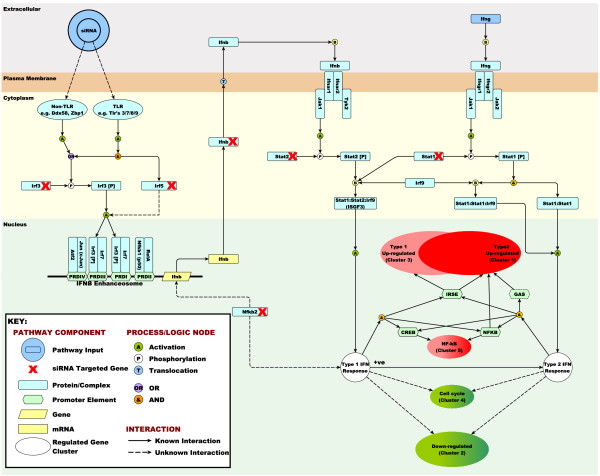
Model of known components of the IFN signalling pathway and explanation of observed results. Transfection of siRNA using Lipofectamine2000 in mouse BMDMs inductes a type I IFN response. This probably occurrs through the activation of pattern recognition receptors (PRRs) by dsRNA and/or liposome complexes. Downstream of PRR activation interferon regulatory factor 3 (Irf3) is phospohorylated and translocates to the nucleus where it which binds to the IFNβ promotor to induce expression of the IFNβ transcript (Ifnb1). It has been proposed that interferon regulatory factor 5 (Irf5) contributes in a similar manner to induce type I IFN during the antiviral response, and components of the NF-kB pathway are also known to contribute at this level. Once induced, the IFNβ acts in an autocrine manner to activate JAK-STAT signalling and subsequent formation of the interferon-stimulated gene factor 3 (ISGF3), a transcription factor complex composed of Stat1, Stat2 and Irf9 proteins. ISGF3 is responsible for driving the expression of type I interferon-stimulated genes via the ISRE (interferon stimulate response element) found within the promoter sequence of many ISGs affected in this study. Our data suggest that siRNAs targeted to the Ifnb1, Irf3, Irf5, Stat1, Stat2 and Nfkb2 transcripts all disrupt the type I IFN response at a similar level, and therefore alter the downstream expression of several hundred IFN-inducible genes in a similar way. Our data also suggest that type I IFN signalling strongly down-regulates cell cycle genes and influences the activity of the NF-κB signalling and many of the genes associated with a type II IFNγ response. Subsequent activation by IFNγ influences the expression of a different but significantly overlapping set of genes and the magnitude of this response is clearly influenced by the prior activation of the cells by type I signalling.